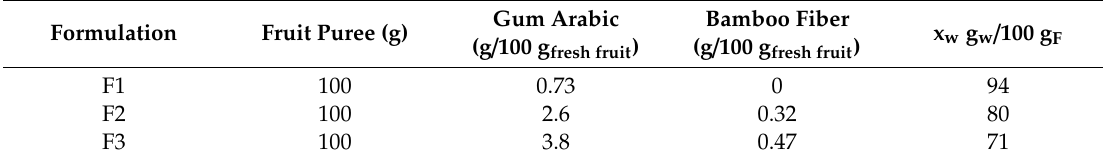
Table 1. Composition of each formulation (F1, F2, and F3) of grapefruit.